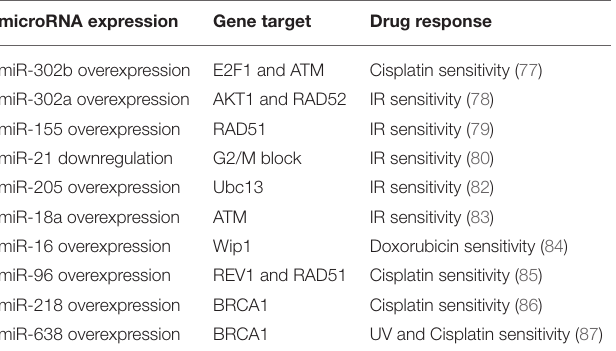
TABLE 1 | miRNAs involved in the chemo- and radio-responsiveness, through the regulation of DNA repair genes. microRNA